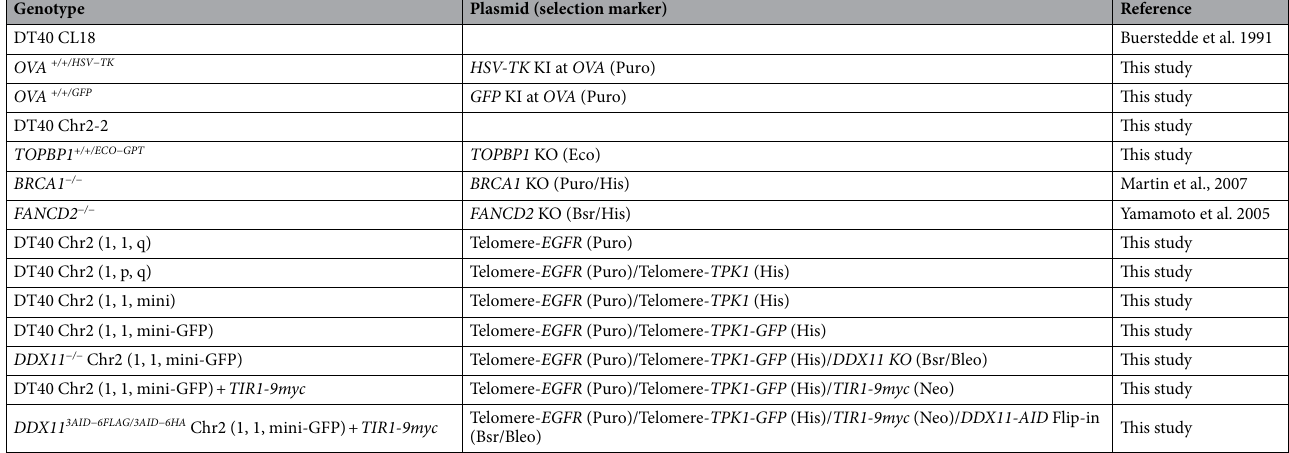
Table 1. DT40 strains used in this study. Bleo bleomycin; Bsr blasticidin; Eco ecogpt; His histidinol; Neo neomycin; Puro